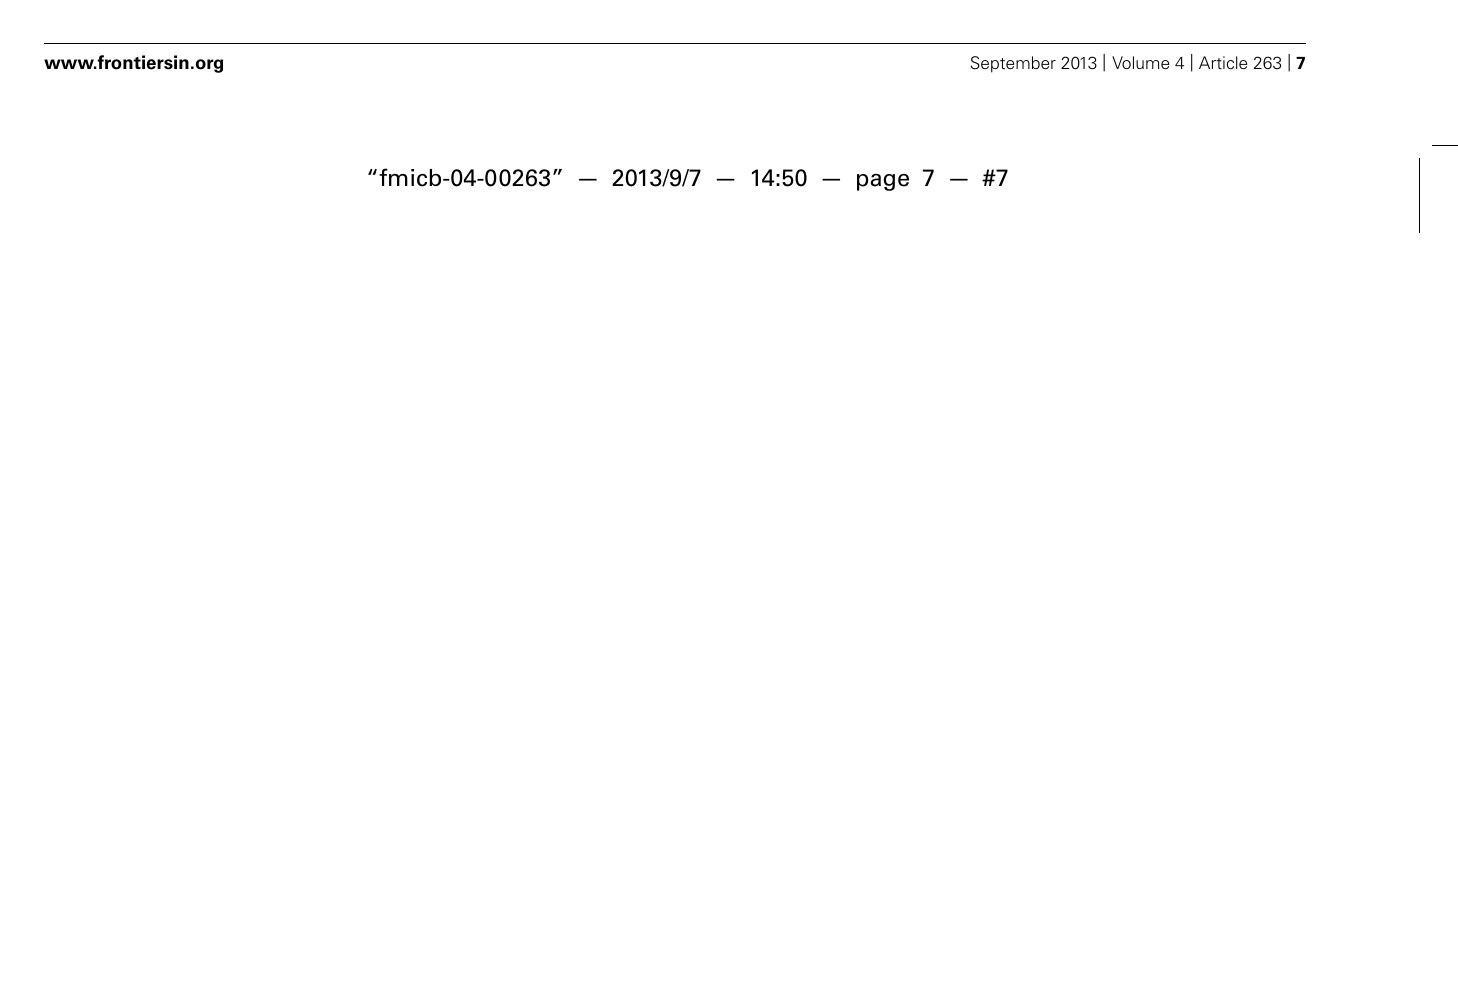
FIGURE 2 |T cell immune response in the asthmatic airways . Naïve T cell is received allergen presentation by DCs. The pathway begins with the development ofTh2 cells and their production of the cytokines IL-4, IL-5, and IL-13. These cytokines stimulate allergic and eosinophilic inflammation as well as epithelial and smooth-muscle changes that contribute to asthma pathobiology.Th9 cell can be induced and stimulate